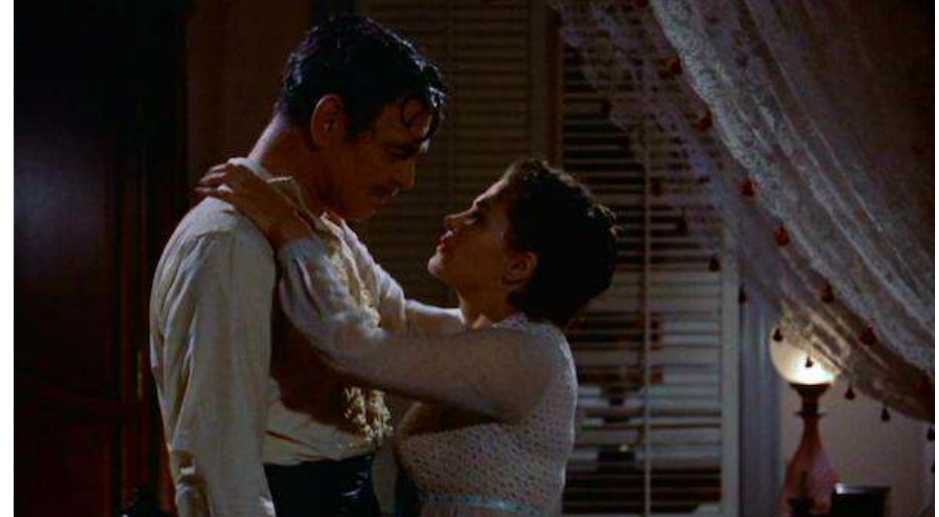
Figure 28: Amantha initiating the first kiss in Bands of